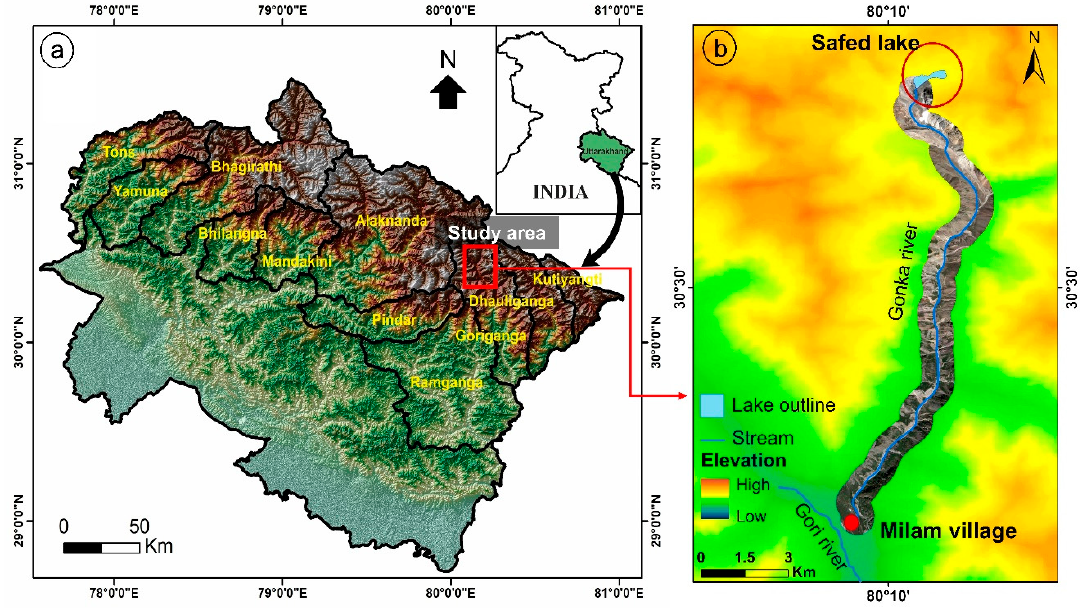
Figure 1. ( a ) The state of Uttarakhand and the location of the study area in the Goriganga basin; ( b ) the location of Safed Lake and Milam village; the village is located at the confluence of the Gorka and the Gori rivers.